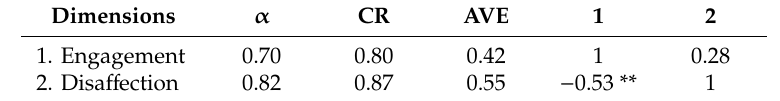
Table 3. Reliability, bivariate correlations, and discriminant validity between the variables of the study. Dimensions α CR AVE 1 2 1. Engagement 0.70 0.80 0.42 1 0.28 2. Disa ff ection 0.82 0.87 0.55 − 0.53 **